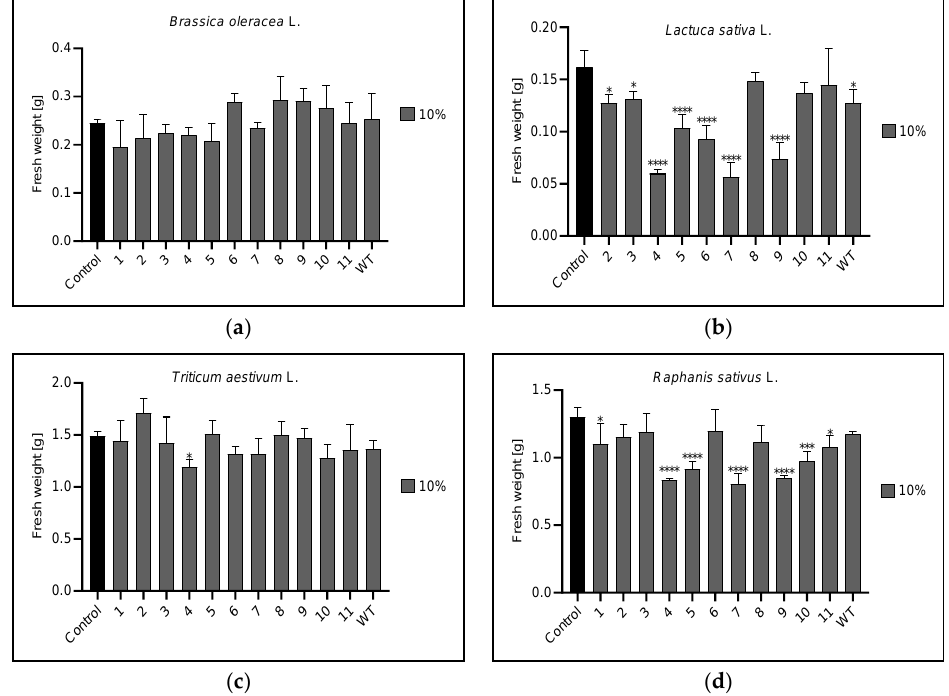
Figure 13 . Fresh weight of broccoli ( a ), lettuce ( b ), wheat ( c ), and radish ( d ) sprouts treated with a 10% concentration for all algae clones tested (1-11, WT) and control (Control). Values represent mean ± SD, n = 10 plants, * p < 0.1, *** p < 0.001, **** p < 0.0001 compared to control (ANOVA and Dunnett ’ s a posteriori test).